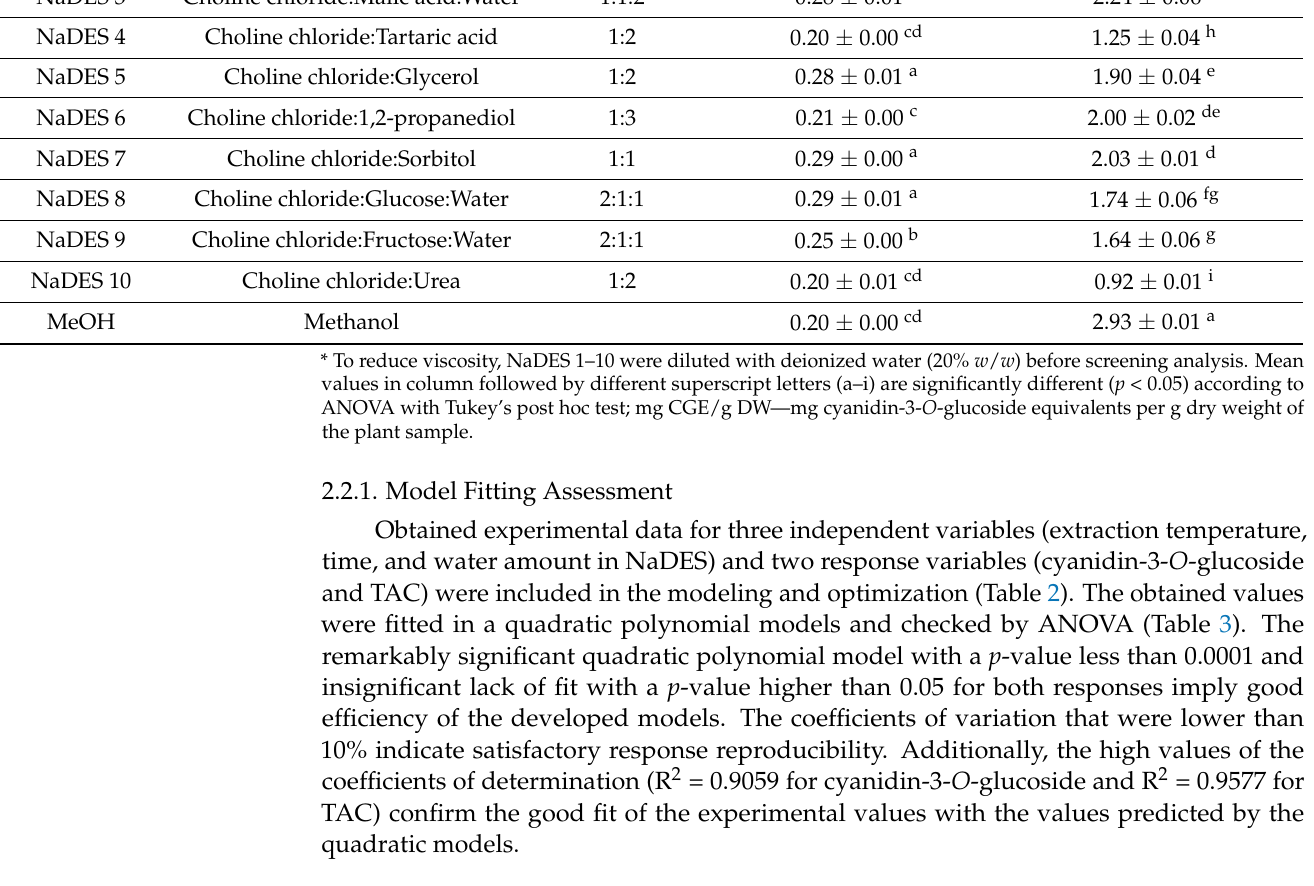
Table 2. Total anthocyanins and cyanidin-3- O -glucoside from bilberry fruits extracted under different conditions defined according to the Box–Behnken experimental